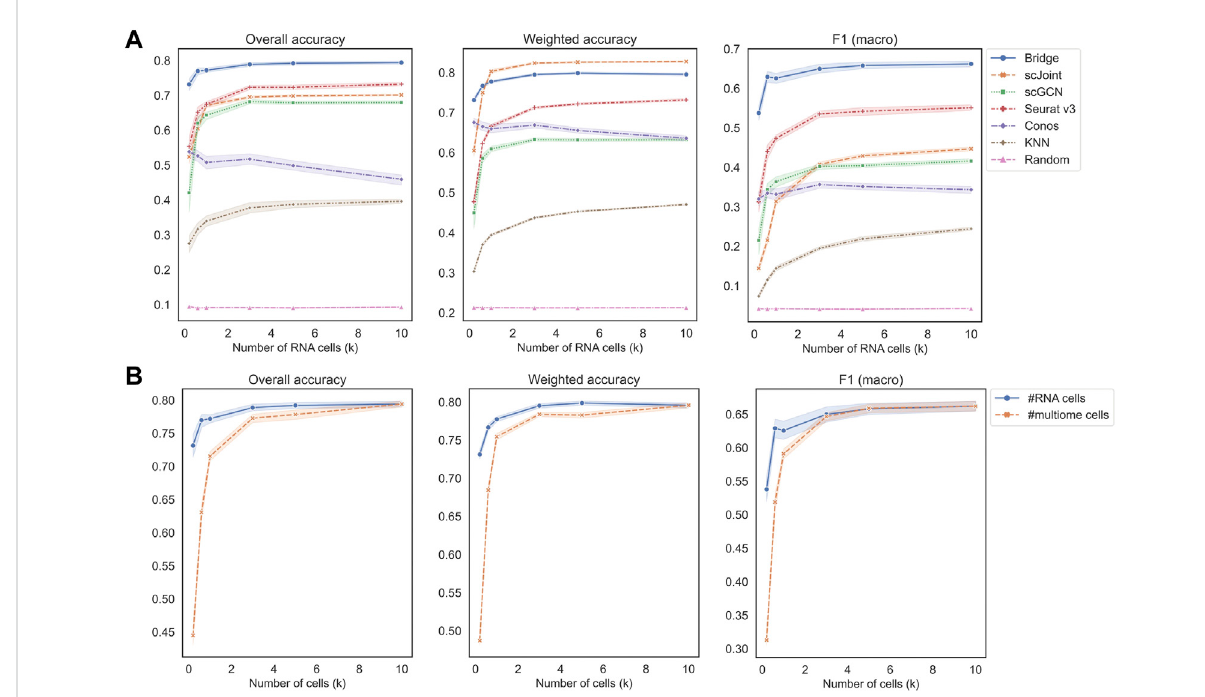
FIGURE 3 Performance of methods on different data scales of BMMC. (A) Change the number of cells in scRNA-seq only, while keeping scATAC-seq and multimodal (for Bridge only) cell numbers as 10 k. Results shown here for Conos were paired with Pagoda2 for data processing. (B) Performance of Bridge while changing number of cells in scRNA-seq and in the multimodal data, respectively. The error band shows the 95% con fi dence